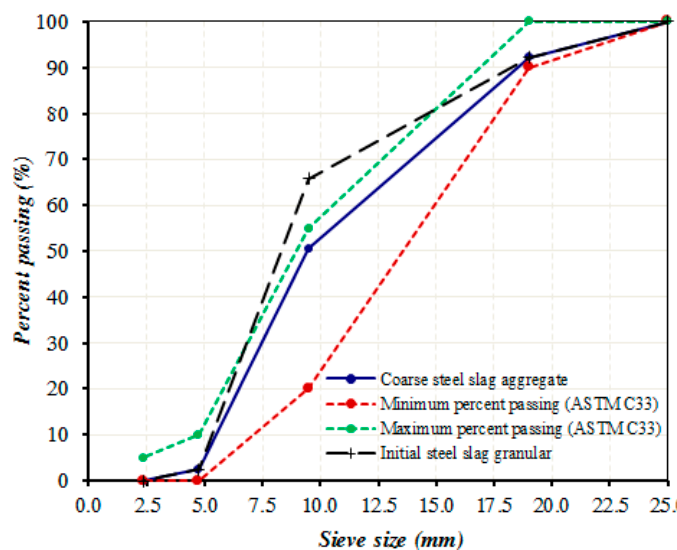
Figure 2. Gradation curves of fine aggregate.